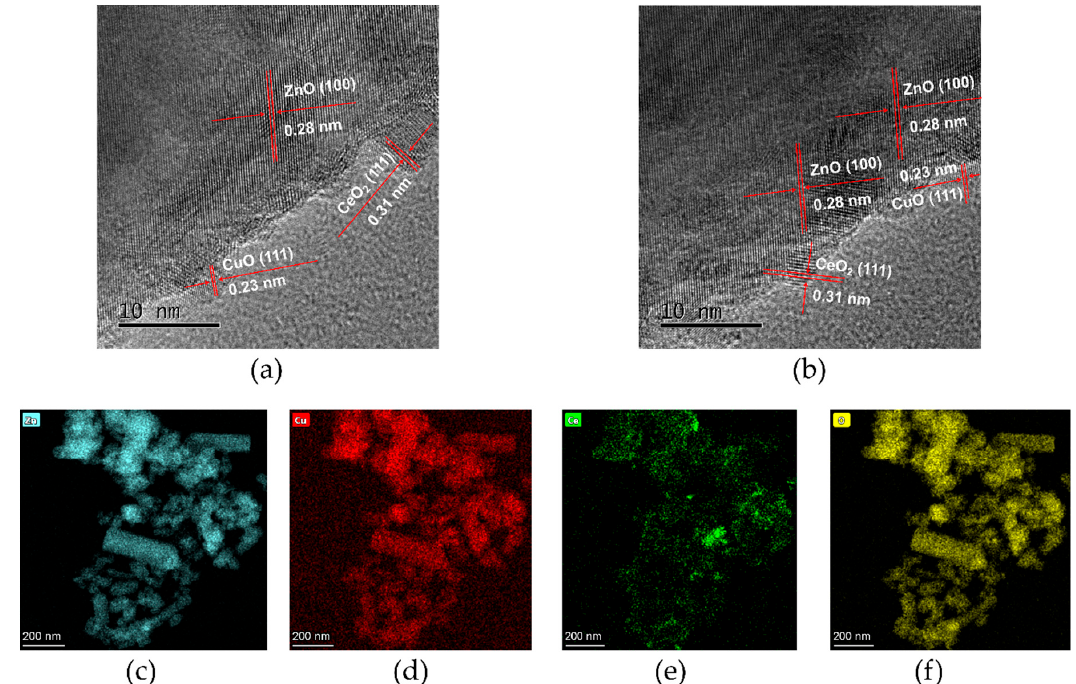
Figure 2. ( a , b ) High-Resolution Transmission Electron Microscope (HR-TEM) images of sample 3%CuO/CeO 2 /ZnO; ( c – f ) element mapping results of sample 3%CuO/CeO 2 /ZnO.